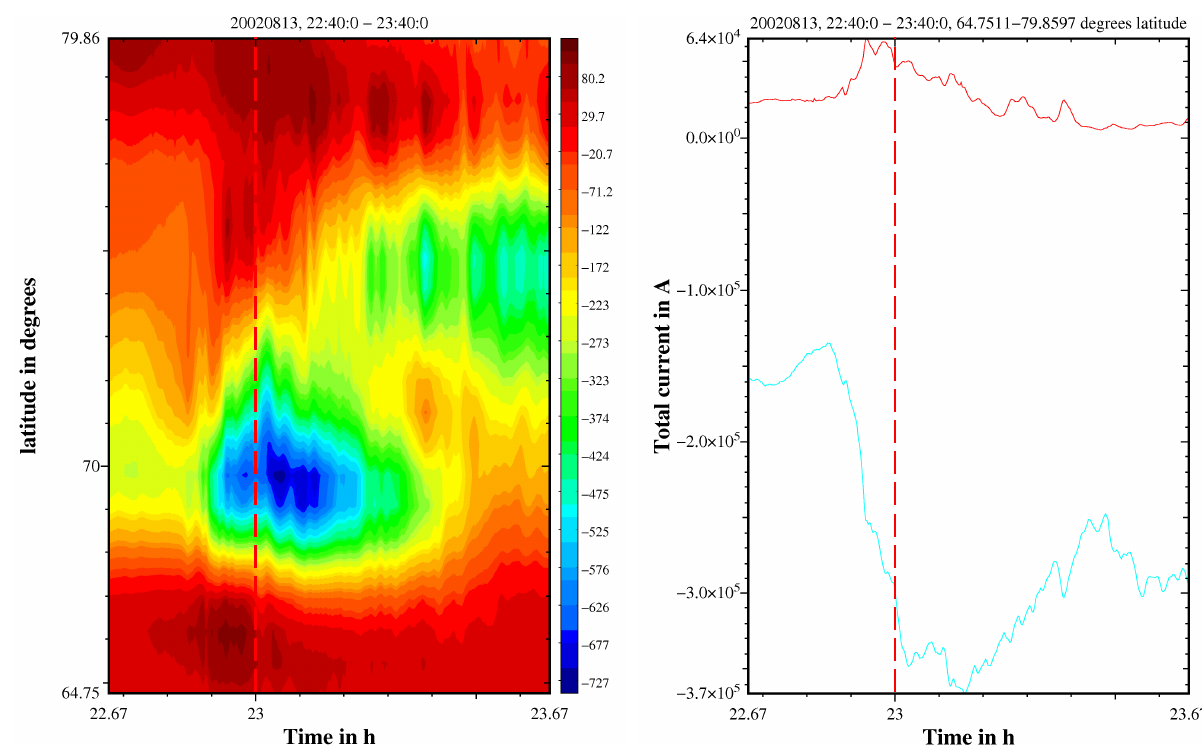
Fig. 7. Left panel: Ionospheric equivalent currents, as derived by the 1-D SECS upward continuation technique from the ground magnetic data, in mA m − 1 , from 22:40–23:40 UT. The dashed red line marks the time of the flux transfer event. Right panel: Total integrated